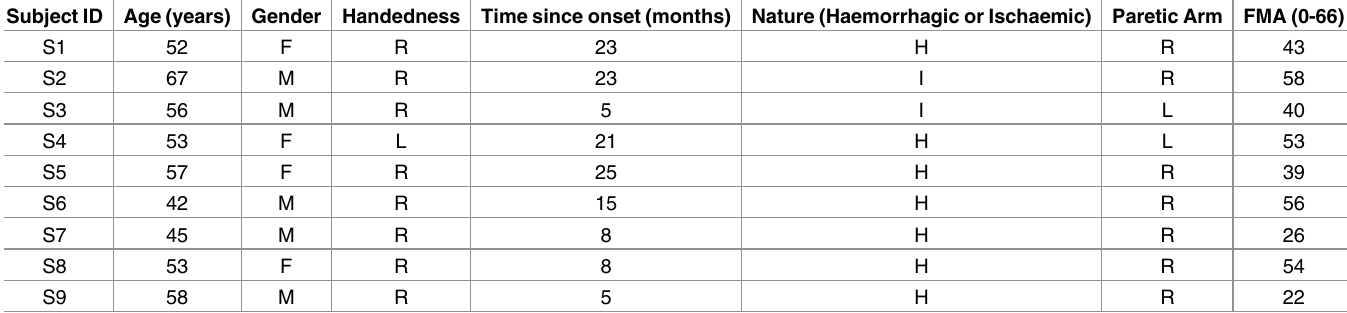
Table 1. Stroke patients